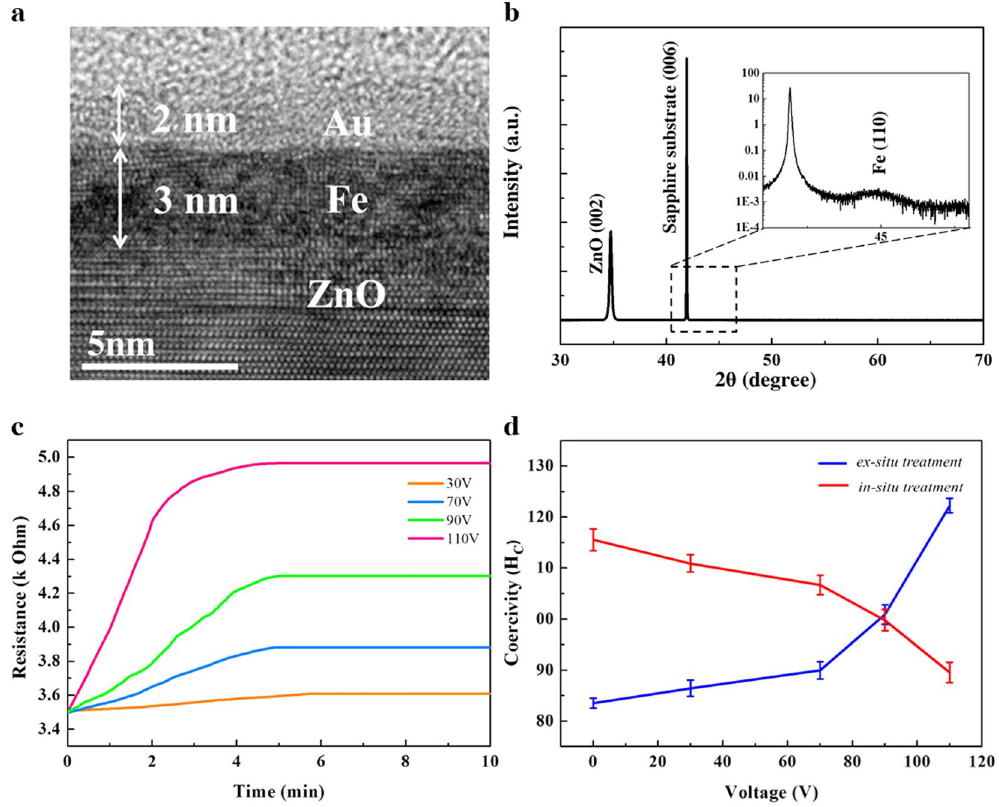
Figure 1. Structural, magnetic and electrical properties of the device. ( a ) Cross-sectional HRTEM imagine and ( b ) XRD pattern of the Au/Fe/ZnO hetero-structure device. ( c ) Time-dependent resistance of the device with 30, 70, 90, and 110 V treatments. ( d ) Ex-situ - and in-situ treatment -dependent H c with varying voltages (MOKE). Inset of ( b ) shows zoom-in information of the Fe